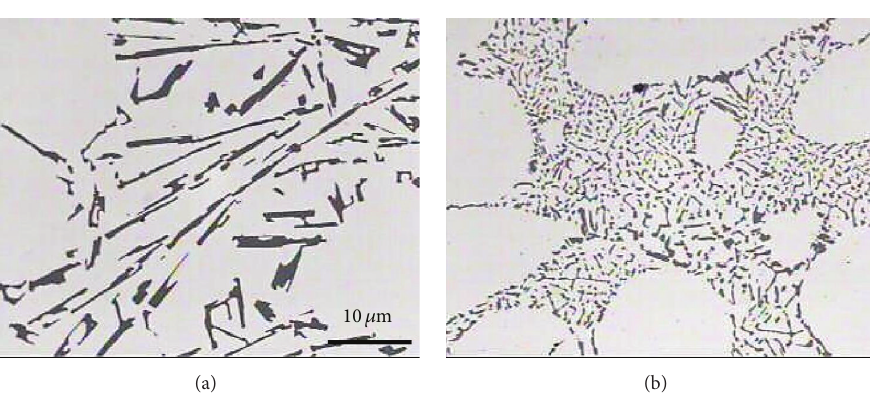
Figure 8: Size and distribution of eutectic Si particles in (a) T0 and (b) T0S 356